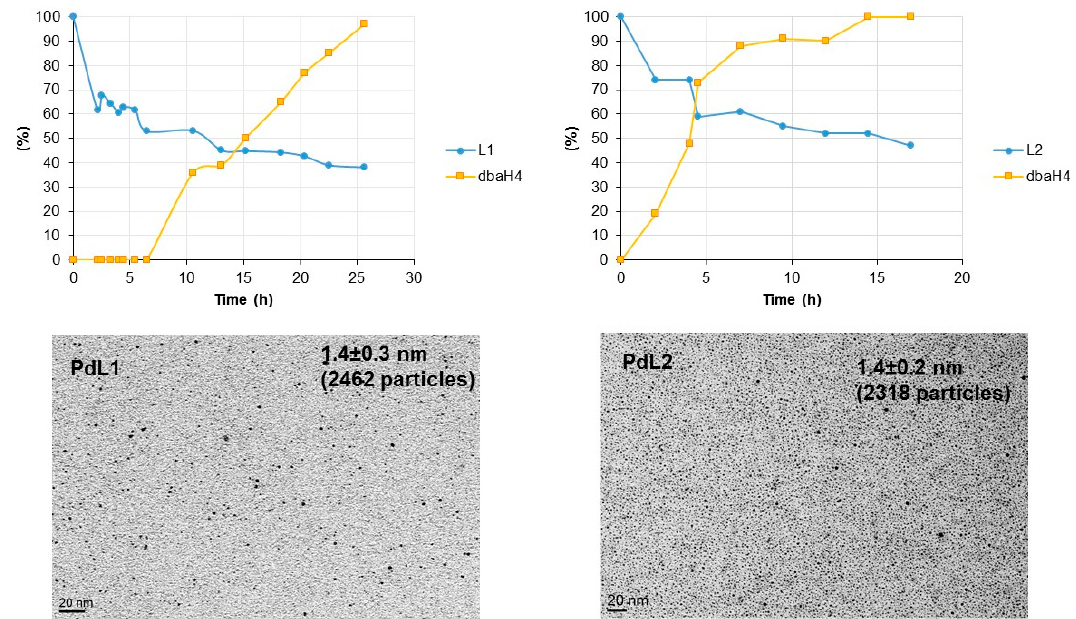
Figure 2. Graphical representations of the data corresponding to the consumption of ligand and decomposition of Pd precursor from the 1 H NMR monitoring of the formation PdNPs with L1 and L2 ( top ); TEM images of PdL1 and PdL2 after total consumption of [Pd 2 (dba) 3 ] ( bottom ). In the case of ruthenium, only 0.4 equivalent of ligand was necessary for the formation of RuNPs, RuL1 and RuL2 (Figure 3). Contrary to the behaviour of the formation of PdNPs, the decomposition